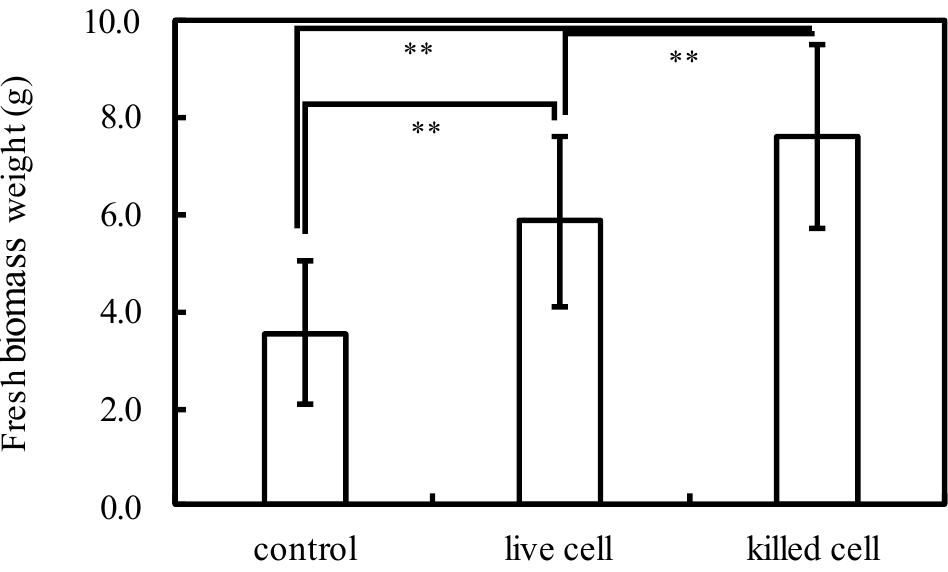
Figure 2. Fresh weight of komatsuna when live or inactivated PNSB (2 × 10 6 cfu mL − 1 ) were sprayed once every 3 days and cultivated for 30 days. Each bar represents the mean ± S.D. ( n = 18). Asterisks indicate significant difference at p < 0.01 (**).